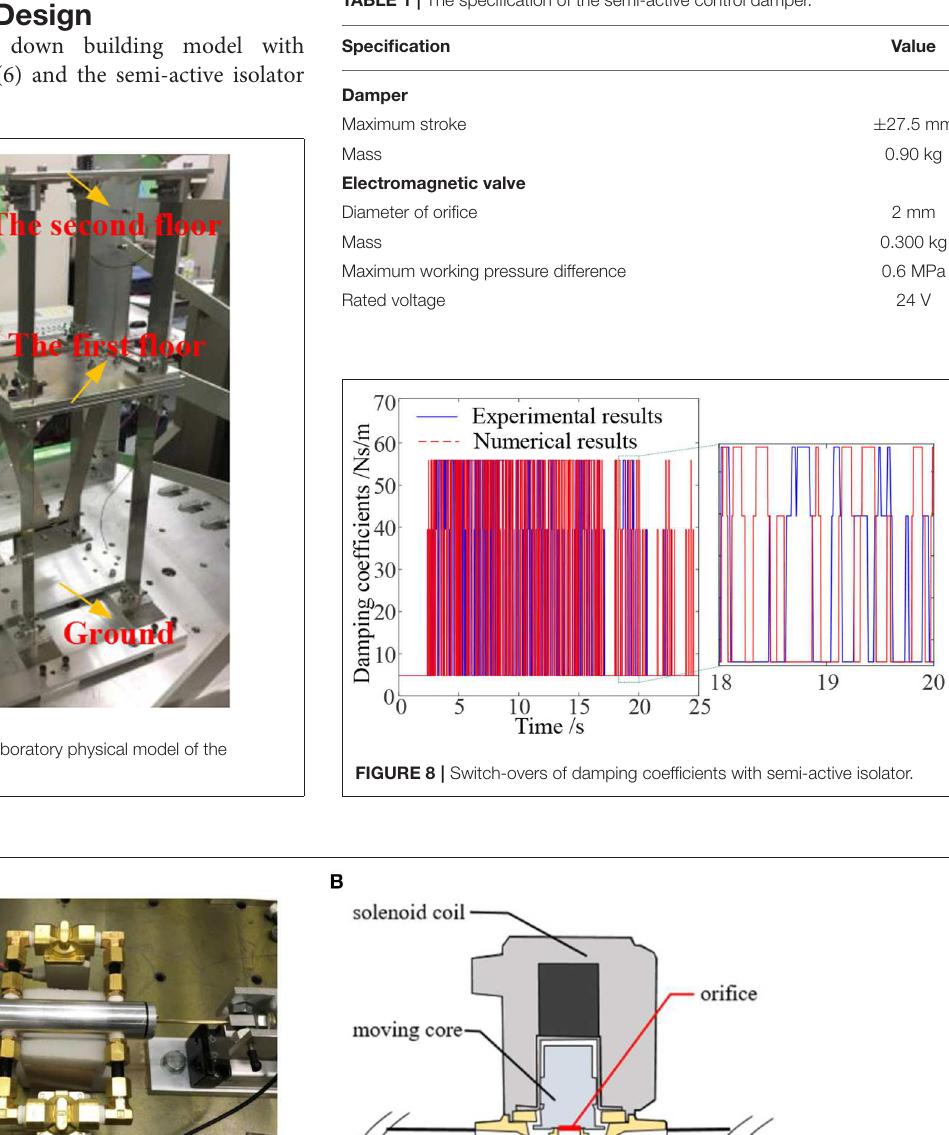
TABLE 1 | The specification of the semi-active control damper.